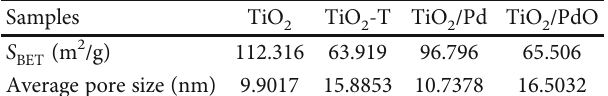
, TiO -T, TiO /Pd, and TiO 2 2 2 2